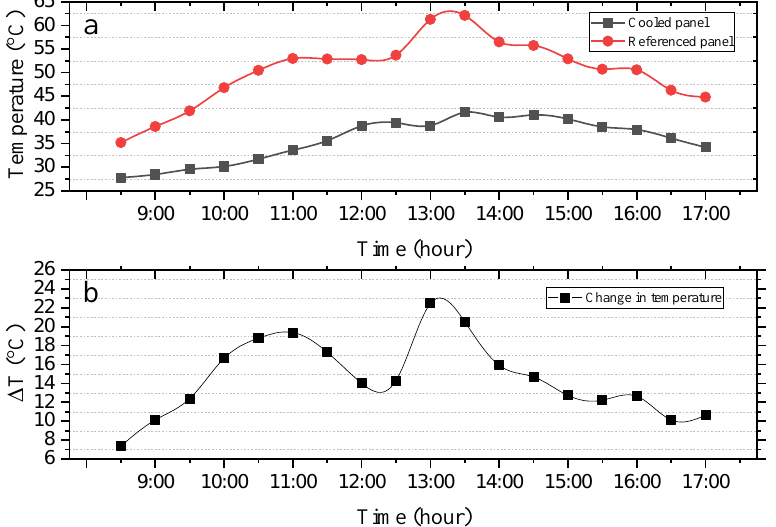
Figure 7. ( a ) Temperature ( b ) change in temperature for the two panels. An infrared thermal image of the front surface for the two panels is presented in Figure 8. This was taken at mid-day, i.e., 12:00 p.m. This is supposed to act as an added backup information to the already obtained results from the thermocouples as presented supra. It gives a graphical presentation of the temperature distribution on each panel. The maximum temperature of the cooled panel is 39.6 °C whiles the referenced panel had a maximum temperature of 50.7 °C. The cooled panel recorded a minimum value of 31.1 °C against 40 °C for the referenced module. In effect, it is clear about the positive effect of the cooling mechanism on the cooled panel, it was able to significantly reduce the temperature of the module. Figure 8. Thermal image for both panels, cooled ( left ) referenced ( right ).